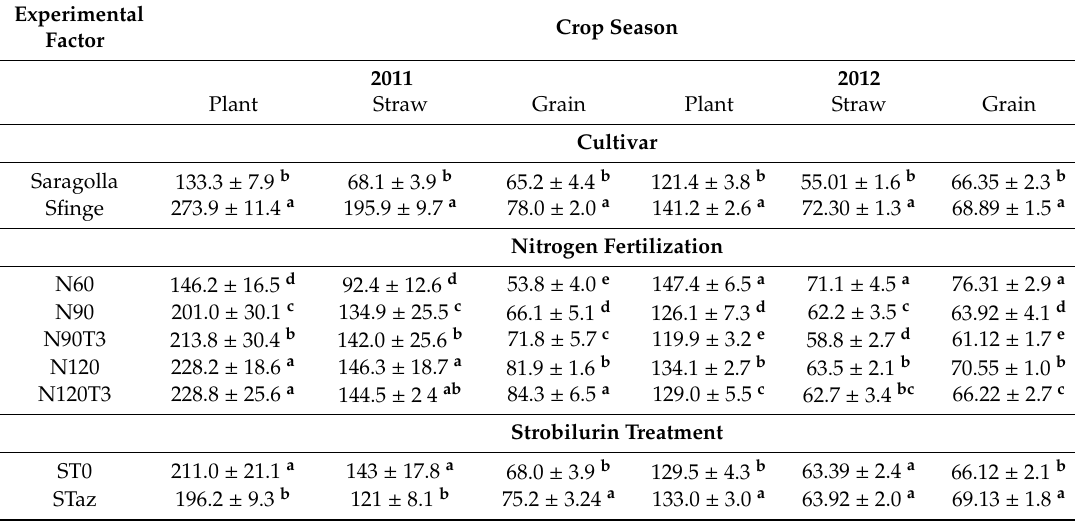
Table 4. E ff ect of cultivar, nitrogen fertilization and strobilurin treatment in 2011 and 2012 for plant, straw and grain N content (kg kg − 1